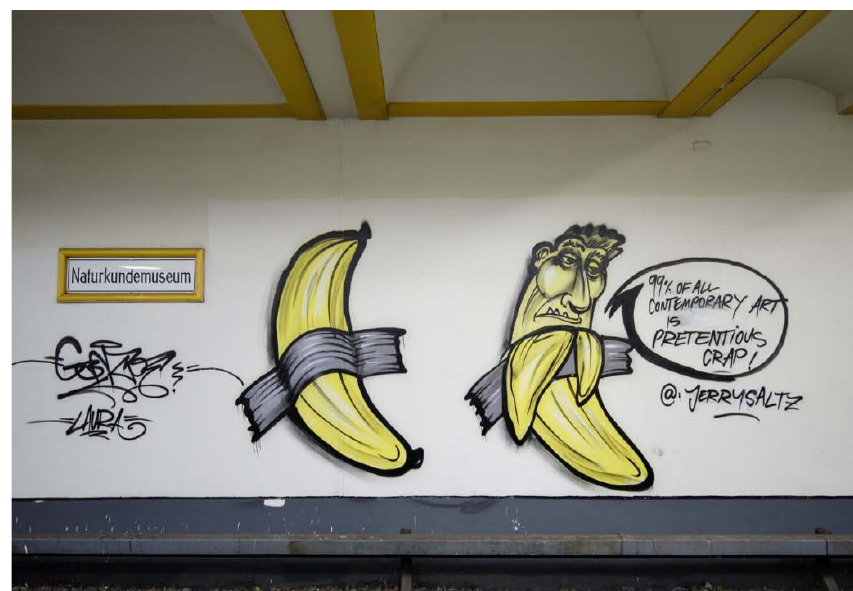
Figure 11. Gonzoe. Jerry Saltz, graffiti referring to Jerry Saltz calling ‘99% of graffiti […] generic crap’* as well as to an artistic exhibit of a taped banana at Art Basel in Miami peeled and eaten by a visitor. Berlin 2020 (Yasharoff